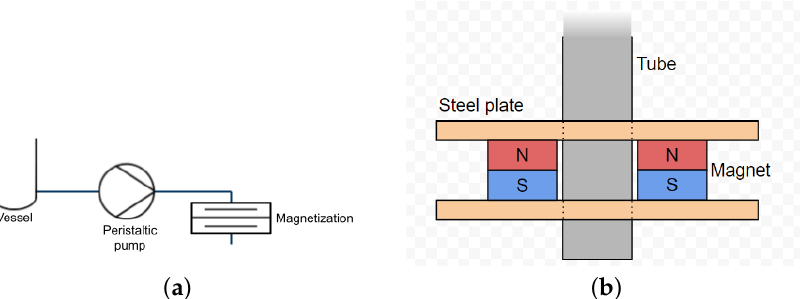
Figure 2. Visual description of the pheromone deposition system implemented. ( a ) Piping diagram describing connections from reservoir vessel, peristaltic pump and magnetization point. ( b ) Detail of the magnetization stage which used two neodymium magnets between steel plates. Pheromone flows through